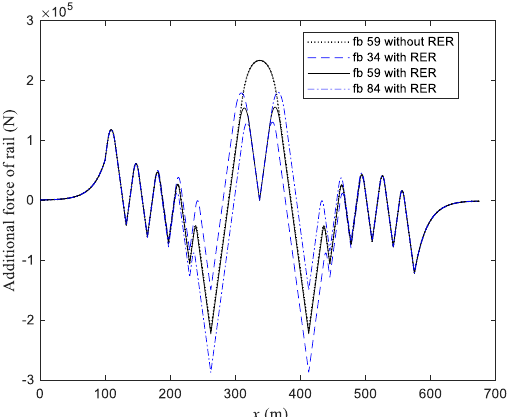
Figure 11. Additional force of rail along its length, with the fixed bearing located at three different positions for the length of 150 m of continuous beam.